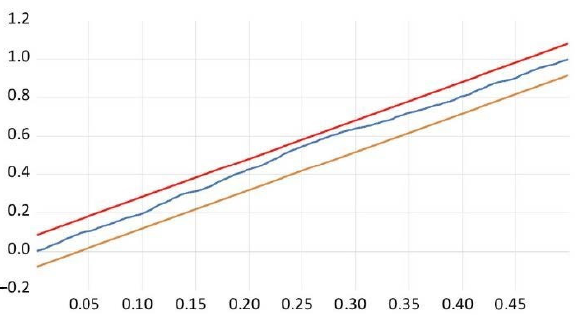
Figure 1. Spectral tests: Normalized integrated spectrum for the USA. Note: This test evaluates the null hypothesis that the data are stationary (white noise). It is based on the normalized integrated spectrum with the following statistic: U p = , where I ( ω ( i )) is the i th maximum. The test statistic (vertical axis) is plotted against its frequency (horizontal axis). If the deviations of the statistic √ from the p /( n /2) line do not exceed ± a 2/ n , the null will not be rejected, where a is set equal to 1.36 for 95%